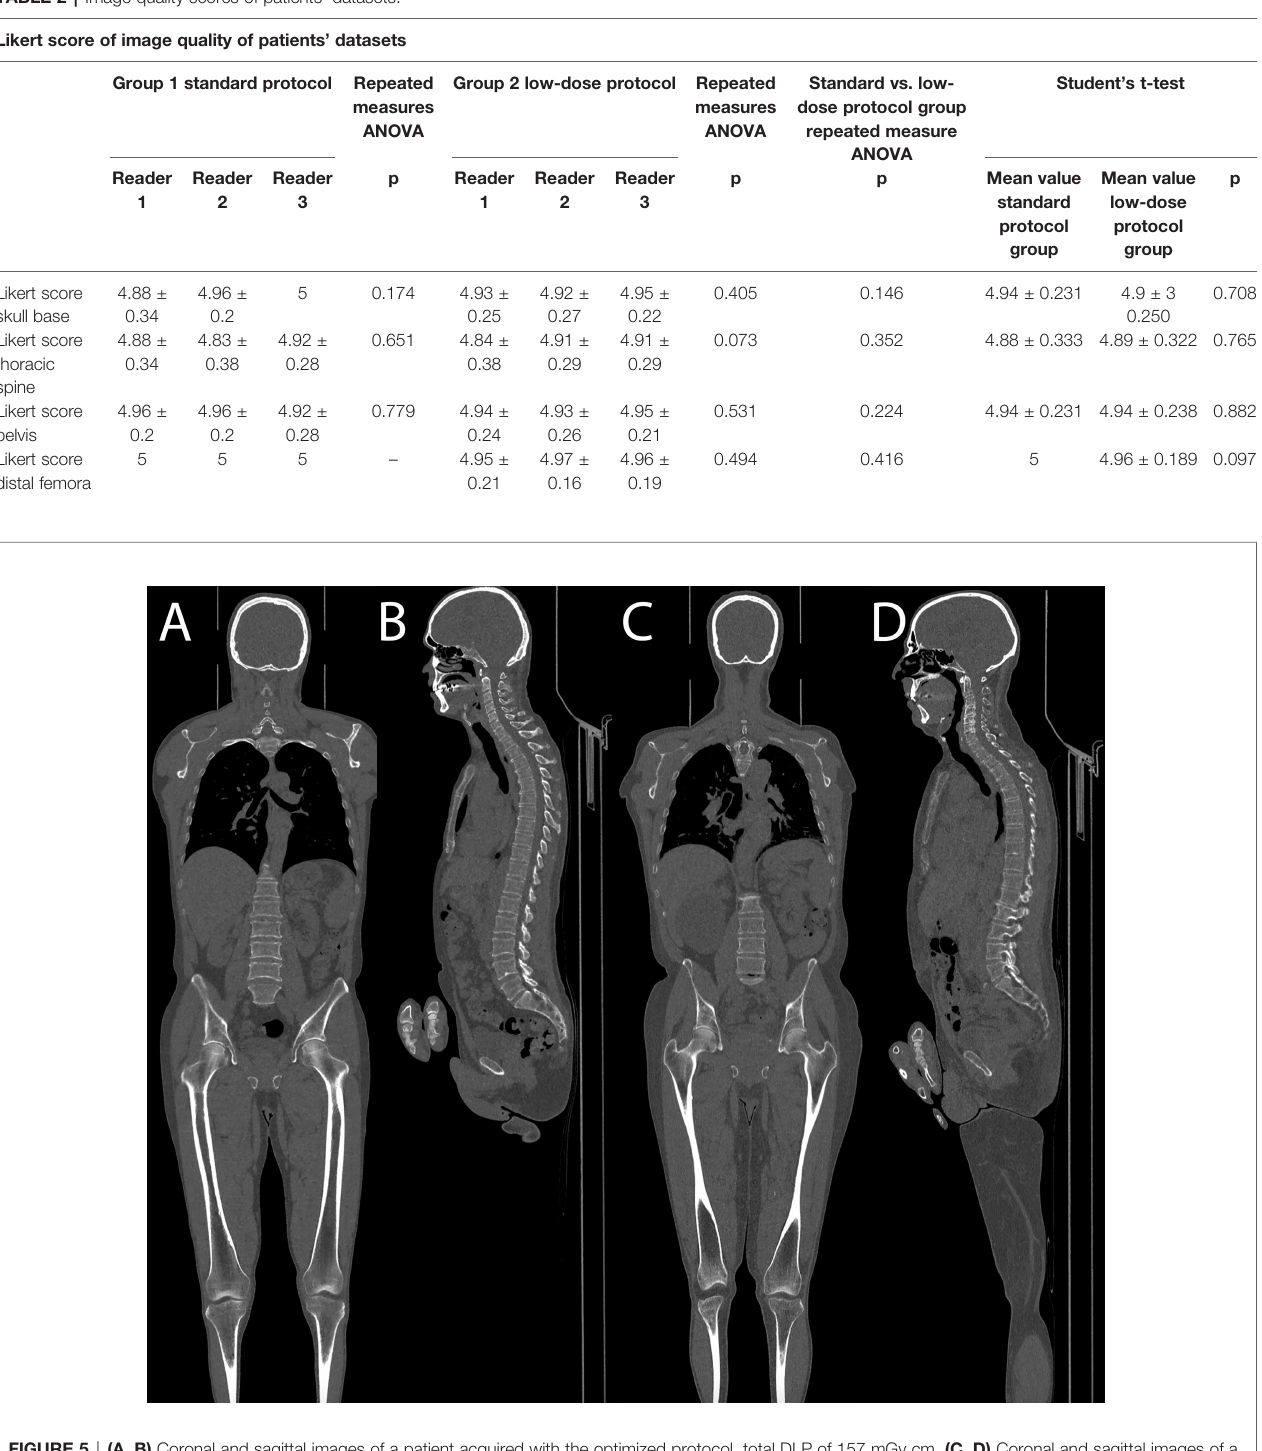
FIGURE 5 | (A, B) Coronal and sagittal images of a patient acquired with the optimized protocol, total DLP of 157 mGy cm. (C, D) Coronal and sagittal images of a patient acquired with the standard protocol, total DLP of 434 mGy